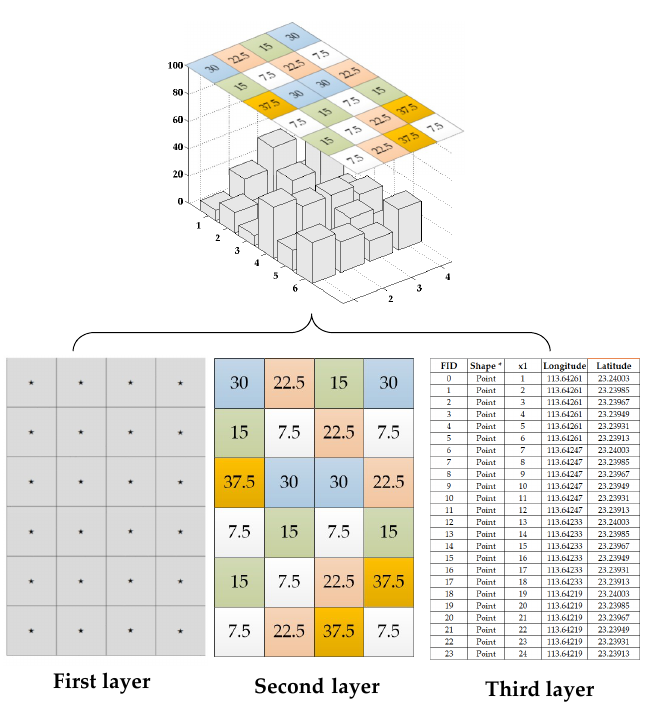
Figure 4. Structure chart of prescription map.